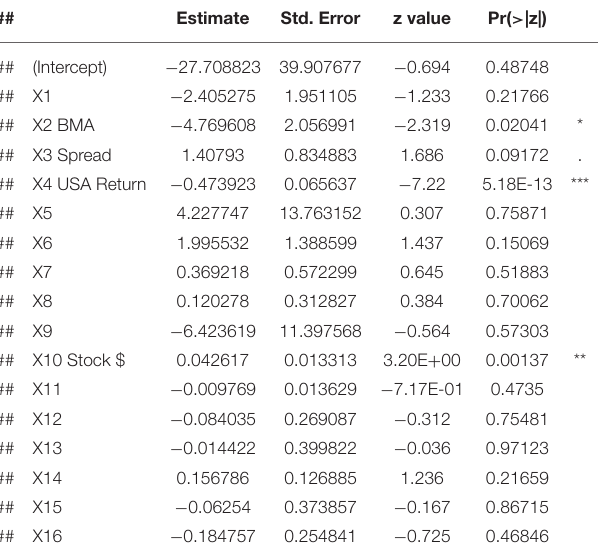
TABLE 11 | Logistic regression results in the